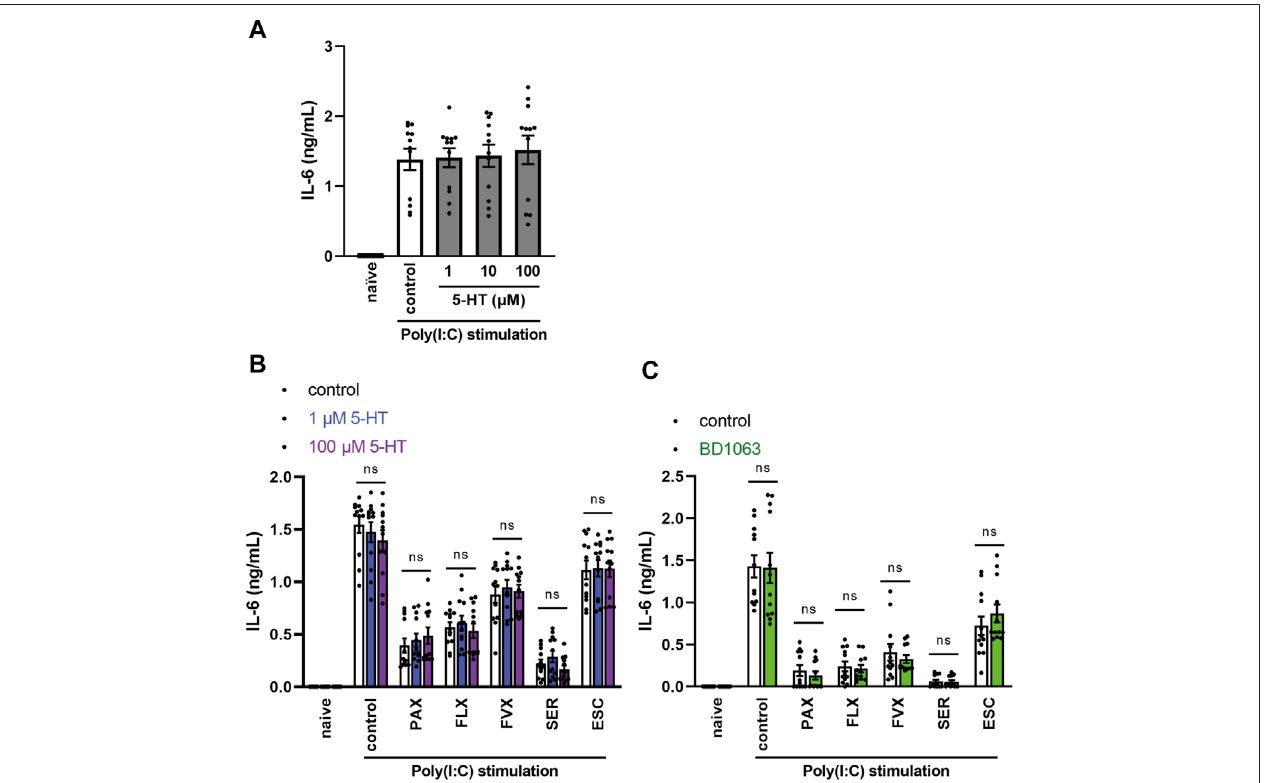
FIGURE 8| Effects ofserotonin or sigma-1 receptor antagonist on the inhibition of TLR3 agonist-induced IL-6 production by SSRIs in J774.1 murine macrophage cells. (A) J774.1 cells were pre-incubated with serotonin (1, 10, 100 µM) for 30 min and then incubated with poly(I:C) (5 μ g/ml) for 6 h (B,C) Cells were pre-incubated with serotonin (1, 100 µM) (B) or sigma-1 receptor antagonist, BD1063 (10 µM) (C) for 30 min, and incubated with each SSRI (10 µM) for 30 min, then incubated with poly(I:C) (5 μ g/ml) for 6 h. IL-6 was measured by means of ELISA. Error bars indicate ±SE ( n = 12, three independent experiments). Statistical analysis was performed by one-way ANOVA followed byDunnett ’ s test (A) , two-way ANOVA followed by Dunnett ’ s test (B) , or two-way ANOVA followed by Bonferroni ’ s test (C) . 5- HT: 5-hydroxytryptamine (serotonin). PAX, paroxetine; FLX, fl uoxetine; FVX, fl uvoxamine; SER, sertraline; ESC, escitalopram.